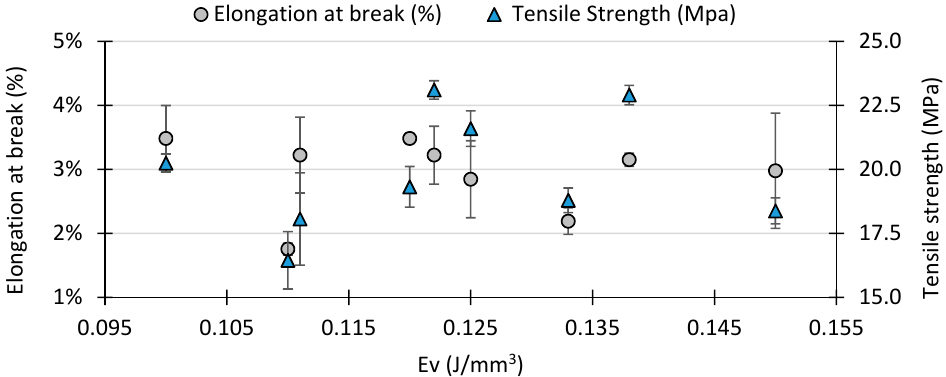
Figure 4. Variation of the tensile strength and the elongation at break with respect to energy density. The tensile strength and elongation at break of the specimens built with different processing parameter combinations are shown in Figure 5, at the same time the standard error of means in displayed for each experimental combination. The graph on the left-hand side illustrates that at fixed 15 W the tensile strength decreases and then increases, at 16.5 W the tensile strength increases and then decreases, and at 18 W the tensile strength consistently increases with increasing scan speed. At the same time, the graph on the right-hand side b shows that at 15 W the elongation at break increases with higher scan speed, at 16.5 W the elongation at break increases and then significantly decreases and at 18 W the elongation at break first decreases and then increases with higher scan speed. In summary, the interaction between power and scanning speed reveals a non-linear phenomenon that cannot be explained in monotonic trends.